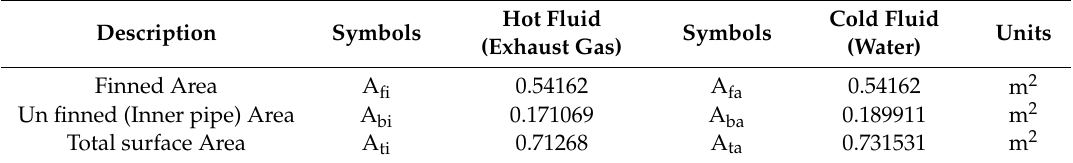
Table 5. Heat transfer surface area of finned heat exchanger.